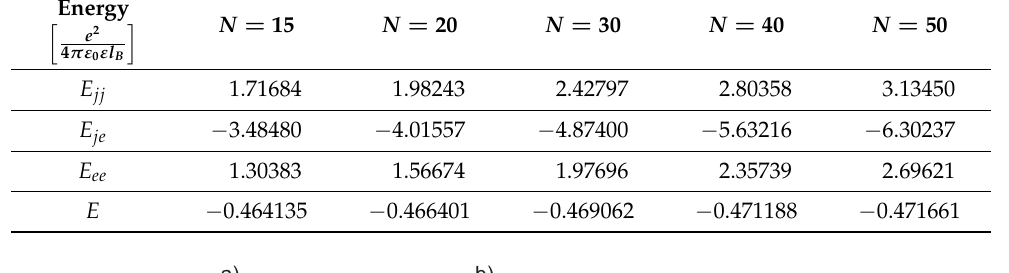
Table 2. Activation energy for exemplary homotopy pattern { x i } = ( 1,2,3 ) for ν = 6 correlations of not-CF type (with q = 3 and x 1 , x 2 = 2 and x 3 = 3).